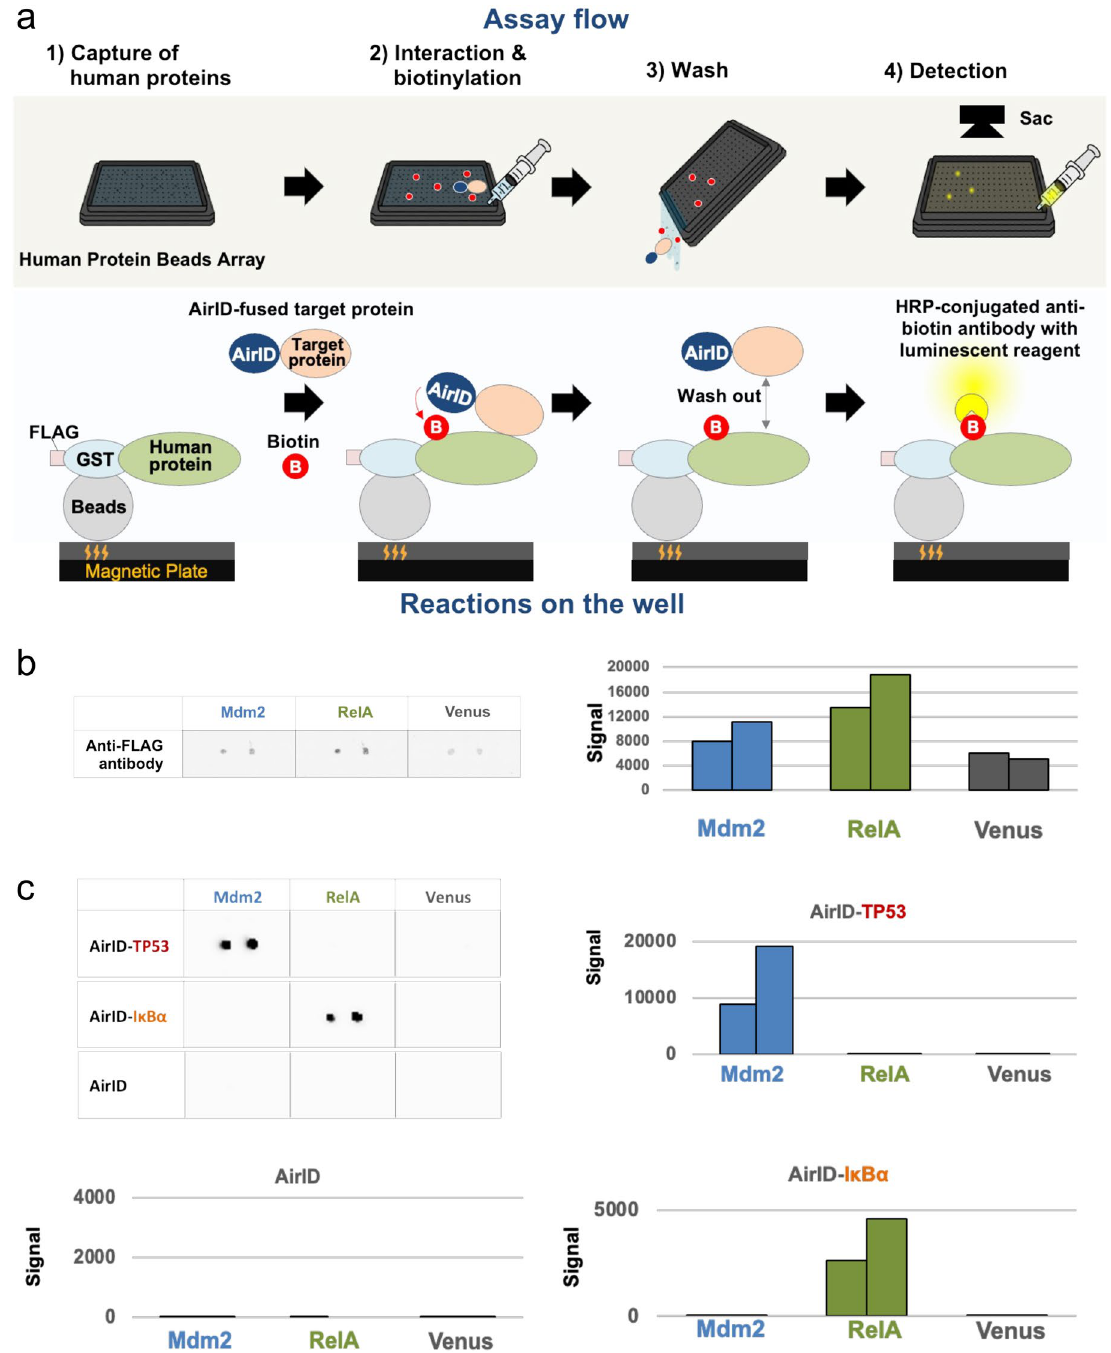
Figure 1. Biotinylation of interacting proteins by AirID-fused proteins using the CF-PPiD system. ( a ) General assay flow of CF-PPiD. The lower panel shows the reactions on the well. First, the human protein beads array is prepared. Human proteins are captured on each well of the array. Next, the AirID-fused target protein, biotin, and ATP are added to the array. The target protein interacts with partner proteins, and then AirID biotinylates the partner proteins in close proximity. Then, the reaction mixture, containing the AirID-fused target protein, is washed out. Finally, the biotin molecules on the partner proteins are detected by chemiluminescence using HRP-conjugated anti-biotin antibody. ( b ) Three FG-proteins (Mdm2, RelA, and Venus) were confirmed to be captured on the array using a fluorescently labelled anti-FLAG antibody. ( c ) Three AirID-fused proteins (AirID-TP53, AirID-IκBα, and AirID alone) and three FG-proteins (Mdm2, RelA, and Venus) captured on the magnetic plate were used as a model system for CF-PPiD. AirID-TP53 and AirID-IκBα specifically biotinylated FG- Mdm2 and FG-RelA, respectively. The bar graph shows the signal intensity. Source data are provided as a Source data